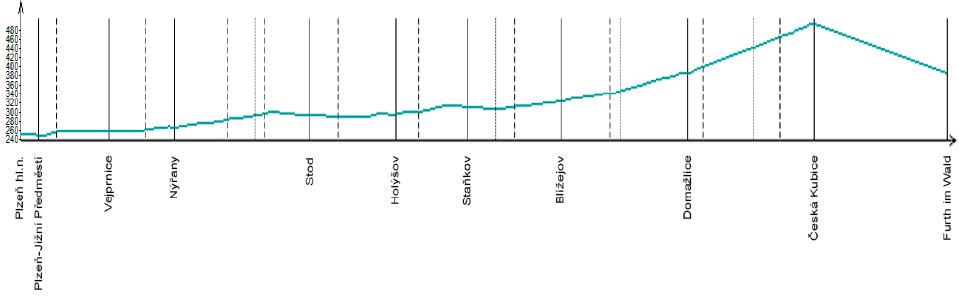
Figure 1. Longitudinal profile of the rail line 180 (data: [1,26]). Source: Authors. Table 1. Intermediate stations of the single-track line 180 Plze ň –Domažlice–Furth im Wald. (data: [1,23,26]). Source: Authors.